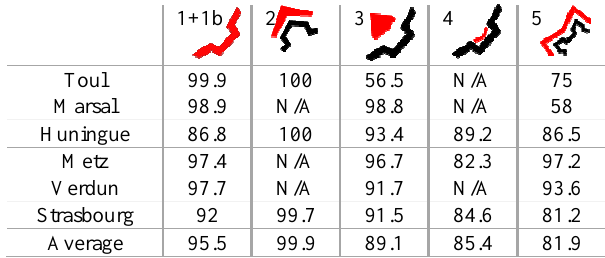
Table 1. Accuracy of each parametric component once adjusted on the sources in percentage of parametric line within the buffer zone.